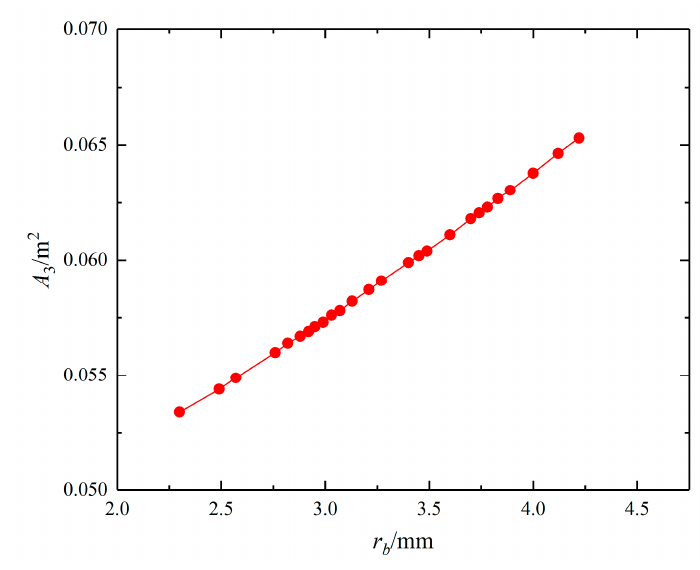
Figure 11. Heat transfer area of the evaporator under different r b .